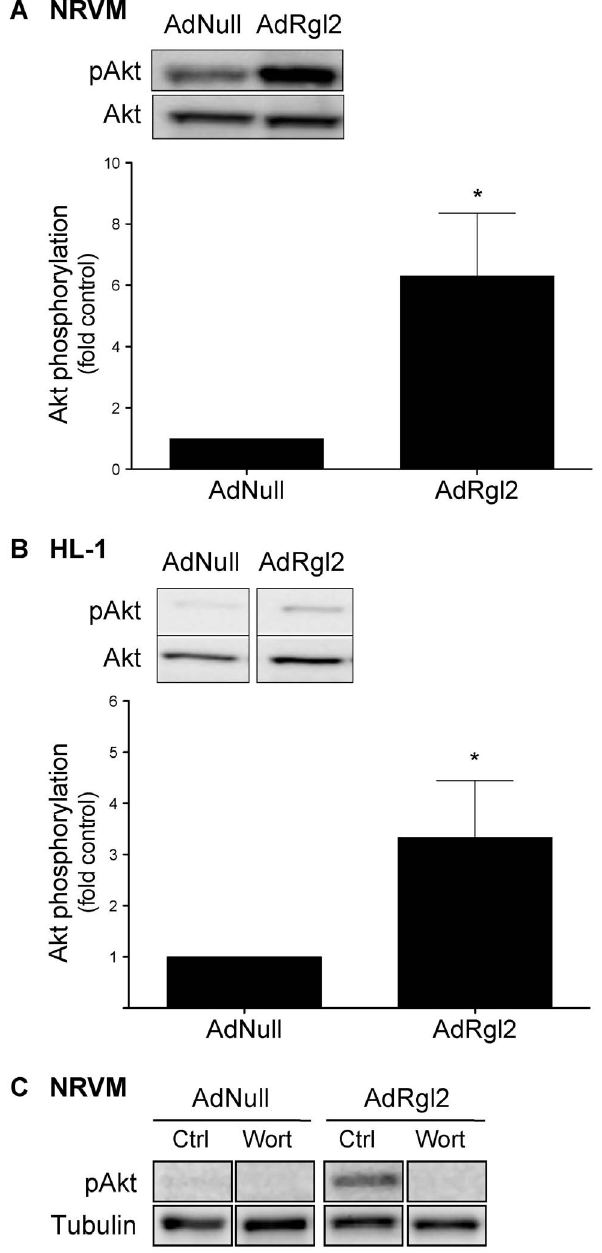
Figure 6. Effect of Rgl2 on the PI3K/Akt signaling pathway in cardiomyocytes. Cell lysates were collected from AdNull or AdRgl2 infected NRVMs ( A, C ) or HL-1 cardiomyocytes ( B ) and immunoblotted with antibodies for pAkt, total Akt, or tubulin. ( A and B ) Rgl2-induced Akt phosphorylation was quantified and normalized to AdNull infected cells. ( C ) AdNull and AdRgl2 infected NRVMs were treated with wortmannin (Wort) for 30 min prior to preparing cell lysates. Shown are representative immunoblots from a single experiment and mean 6 SEM of at least 3 separate experiments. * denotes significant difference from AdNull infected cells.